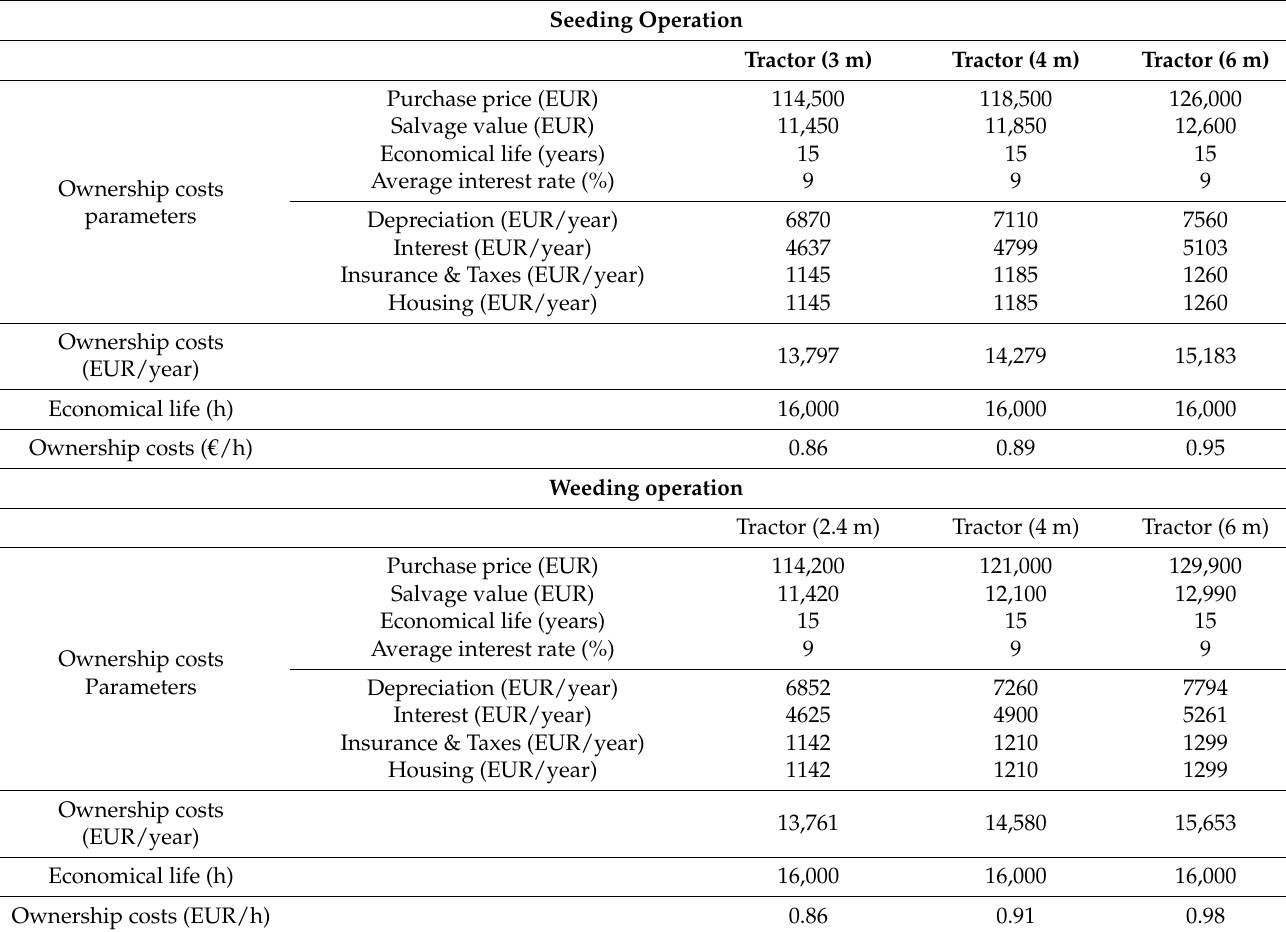
Table 13. The calculation of ownership costs for the tractor in seeding and weeding operations considering the lowest purchase price for the tractor from the mentioned